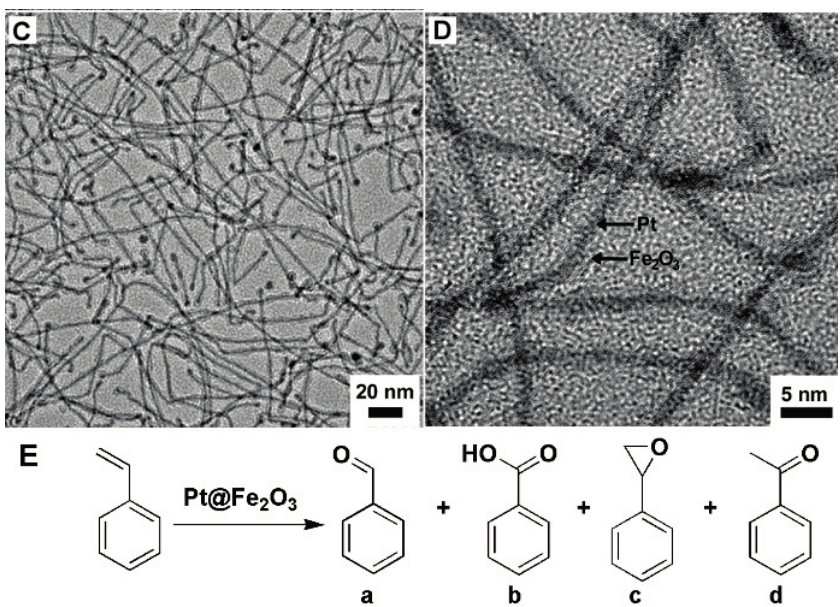
Figure 2. ( A ) The TEM and ( B ) high resolution TEM images of FePt NWs; ( C ) The TEM and ( D ) high resolution TEM images of Pt@Fe 2 O 3 NWs; ( E ) The oxidation of styrene using Pt@Fe 2 O 3 NWs as catalysts [23].